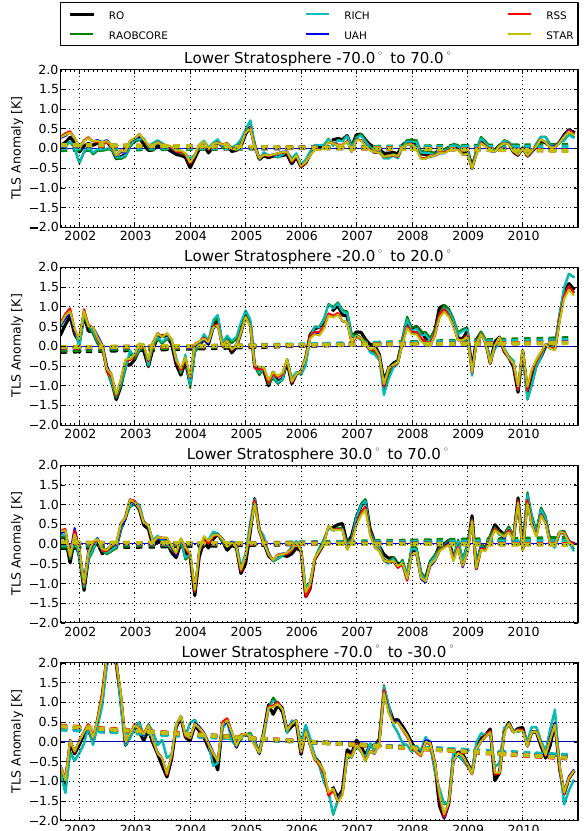
Fig. 8. TLS anomaly time series for all datasets, shown for quasi- global, tropical, and NH/SH extratropical zonal bands (top to bot- tom). The linear regression lines are shown as dashed